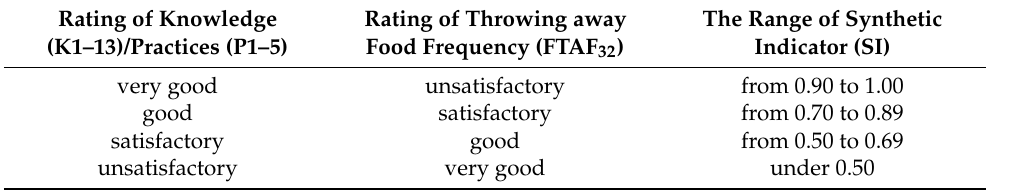
Table 2. Applied ratings and the ranges of the synthetic indicator relating to respondents’ knowledge and practices and throwing away food